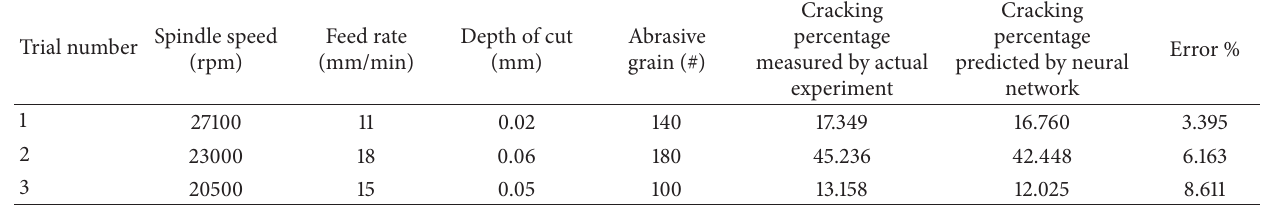
Table 8: Comparison of cracking percentage between neural network and actual